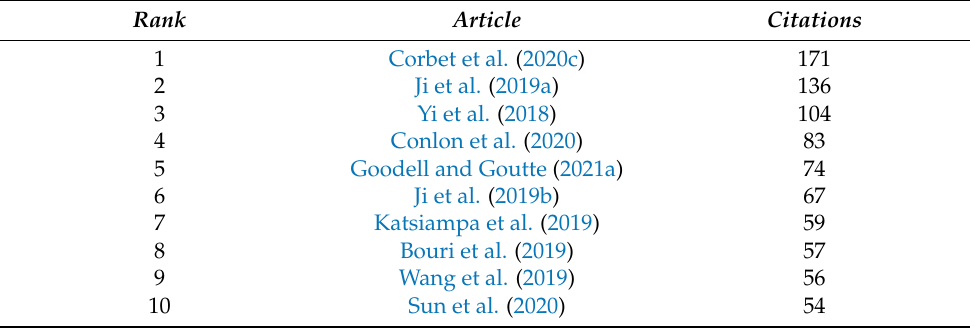
Table 1. Top 10 articles by number of citations (1975 Citation and 146 Publications).